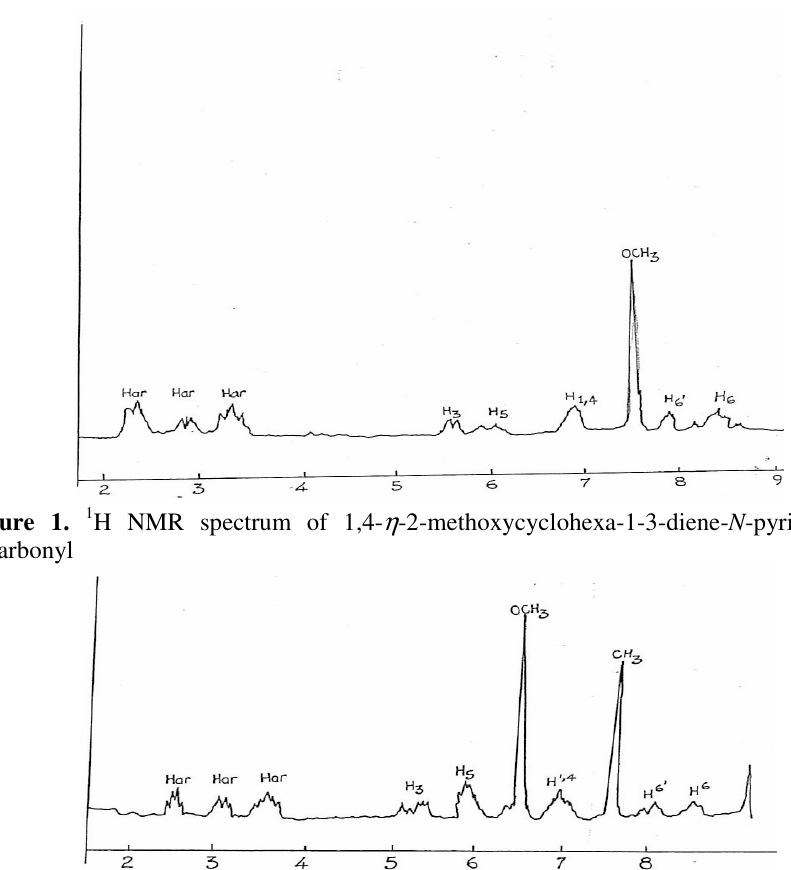
Figure 2. 1 H NMR spectrum of 1,4- η -2-methoxycyclohexa-1-3-diene- N -2 methylpyridino iron tricarbonyl